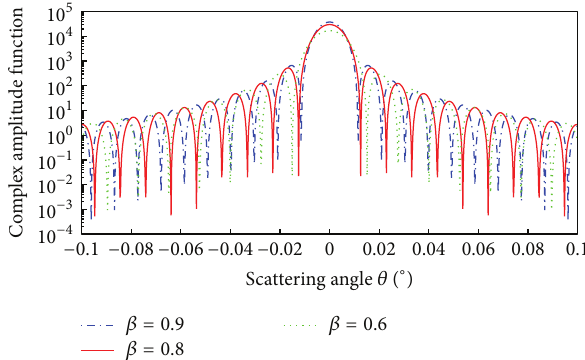
Figure 3: Diffraction of elliptical section obtained by 𝑎 = 3 mm for different shapes.